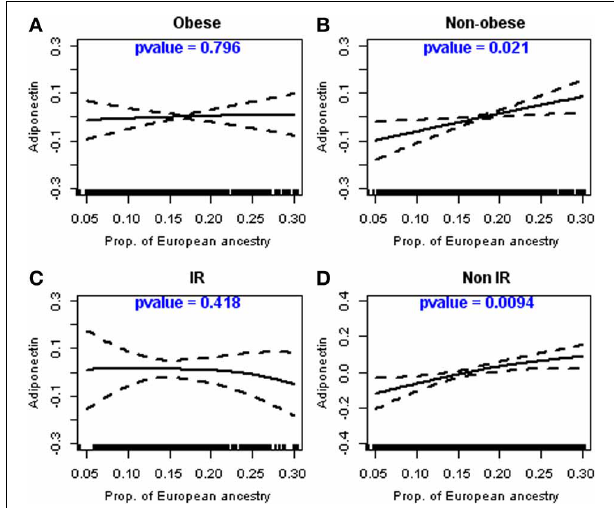
FIGURE 1 | Linear relationship between adiponectin and the proportion of European ancestry in non-obese and non-insulin resistant participants. Legend: Relationship between the proportion of European ancestry and adiponectin levels (log-transformed), as described using cubic regression splines, stratified by obesity and insulin resistance levels; (A) Obese participants; (B) Non-Obese participants; (C) Participants with insulin resistance (IR); (D) Participants without insulin resistance